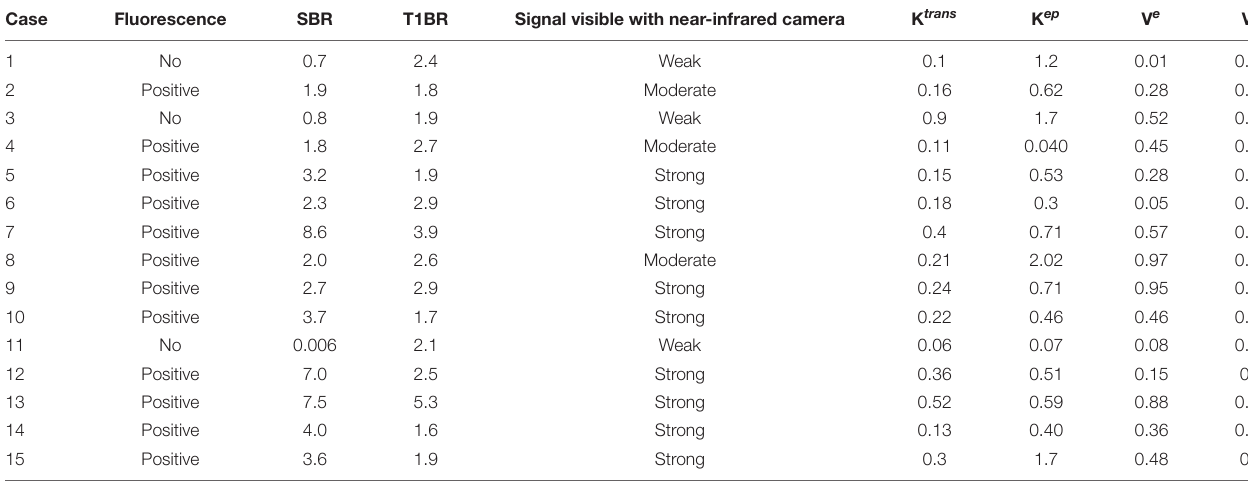
TABLE 2 | Data of 15 patients with intracranial meningioma, including fluorescence, NIR tumor SBR, ratio of Gd-enhanced T1 tumor to normal brain, signal intensity of fluorescence in NIR and the scores of K trans , K ep , V e , and V p on MRI. Case